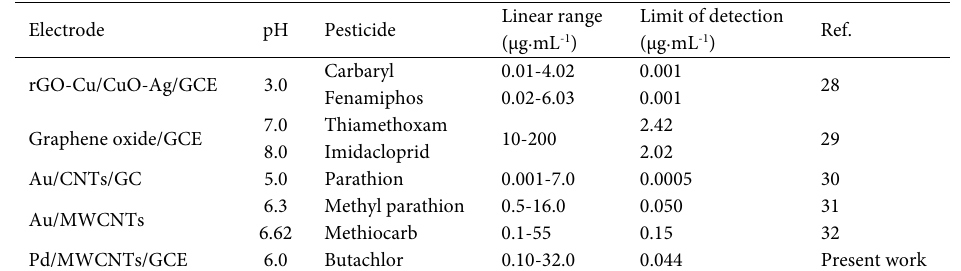
Table 2. Comparison between the proposed Pd@MWCNTs sensor with some published sensors for detection of other Electrode